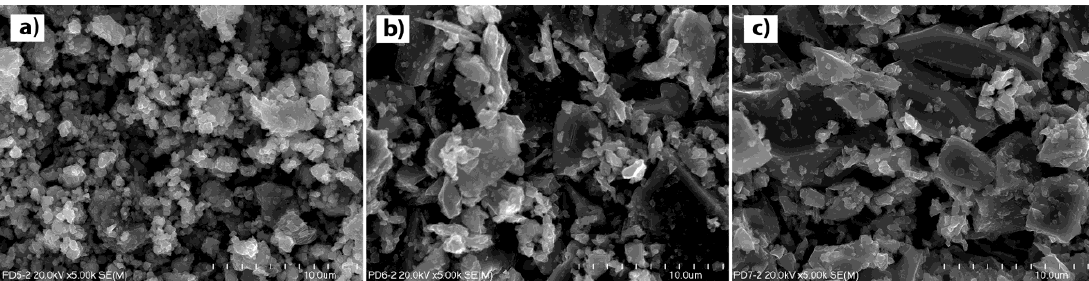
Figure 3. Scanning electron microscopy photographs of the surface of the CaCu 3 − x Mg x Ti 4 O 12 samples sintered at 1075 ◦ C for 2 h, where: ( a ) x = 0.0; ( b ) x = 0.2; ( c ) x = 0.4.